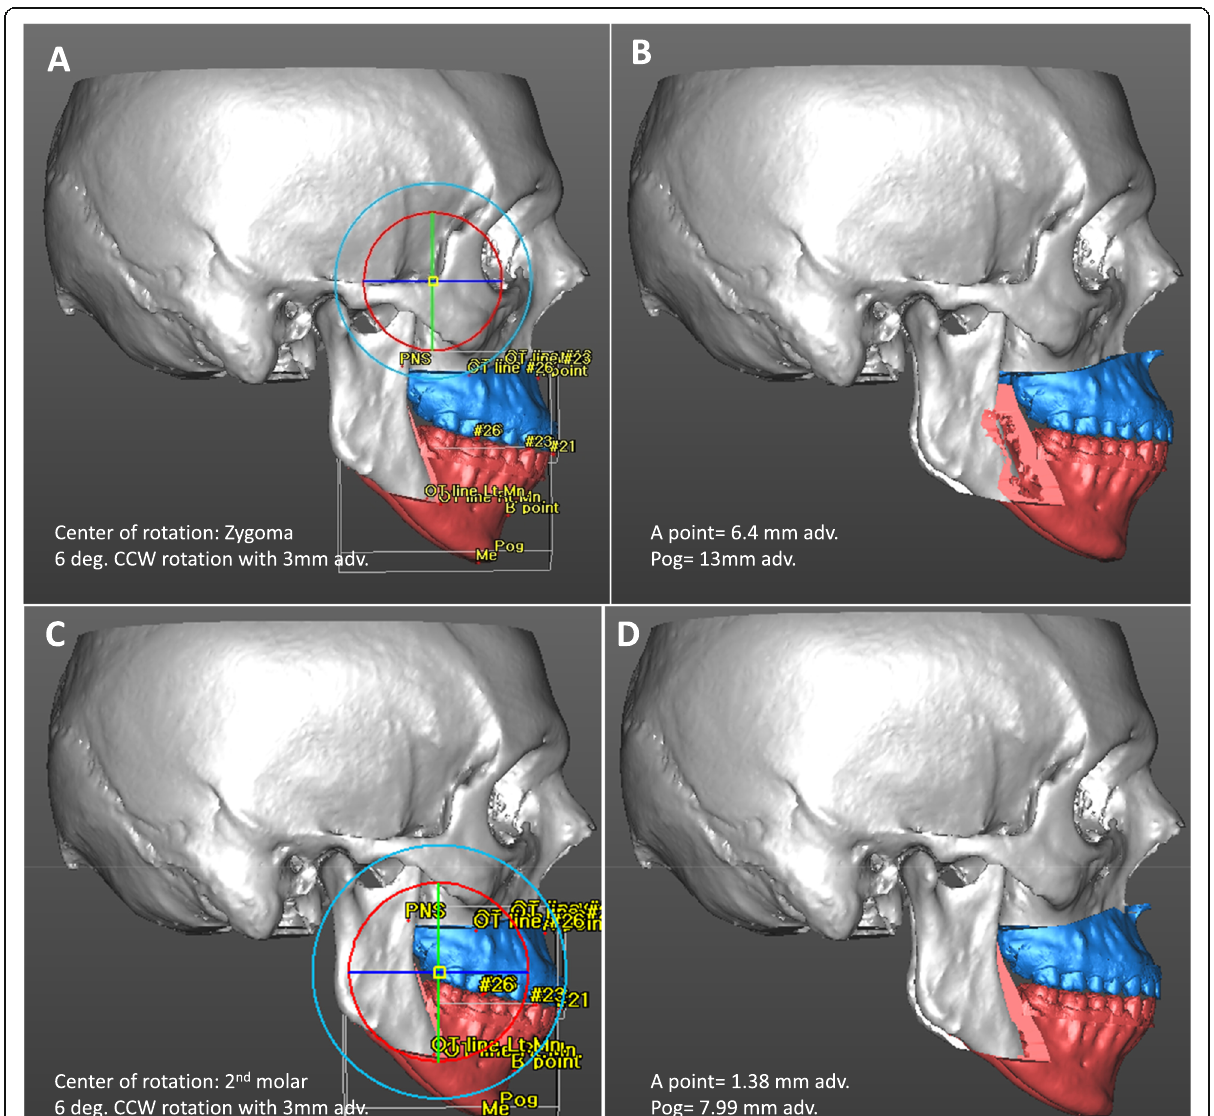
rotation, the amount of advancement can vary. A rotation point located in zygomatic area ( a ) can mobilize Pog more anteriorly ( b ) than those located in distal part of upper 2nd molar ( c , d ). In this context, the location of rotation point should be determined under consideration of